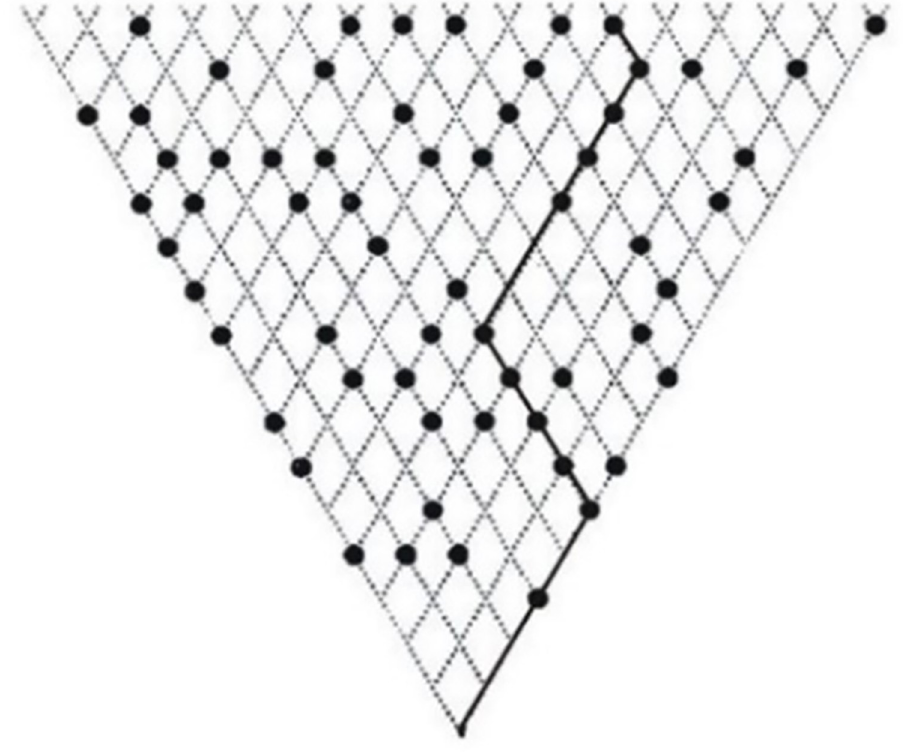
Fig 1. Sample item of the Perceptual Maze